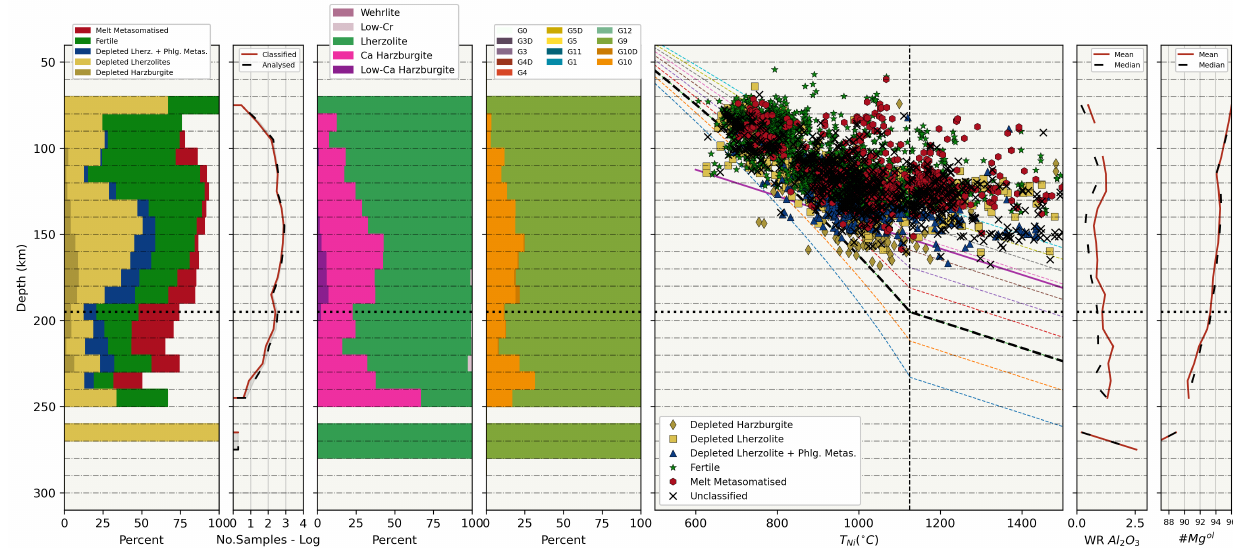
Figure 9: Composition and thermal structure gathered from garnet xenocrysts thermobarmetry and chemical classification meth- ods, with all calculations and plotting performed in Thermobar . Data is taken from Özaydın et al. [2021]. Compositional sections are reported with histograms at each ten-kilometre section. From left to right; histogram of CARP classification scheme [Griffin et al. 2002], number of samples that could be classified with CARP scheme, CaO-Cr O based garnet classification scheme, the 2 3 garnet classification scheme of Grütter et al. [2004], calculated P - T of garnet xenocryst samples against the chosen generalised continental geotherm (37 mW m − 2 ), whole-rock Al O content calculated from Y-content of garnets [O’Reilly and Griffin 2006], 2 3 and Mg# contents of olivine co-existing along garnet calculated with the method of Gaul et al.